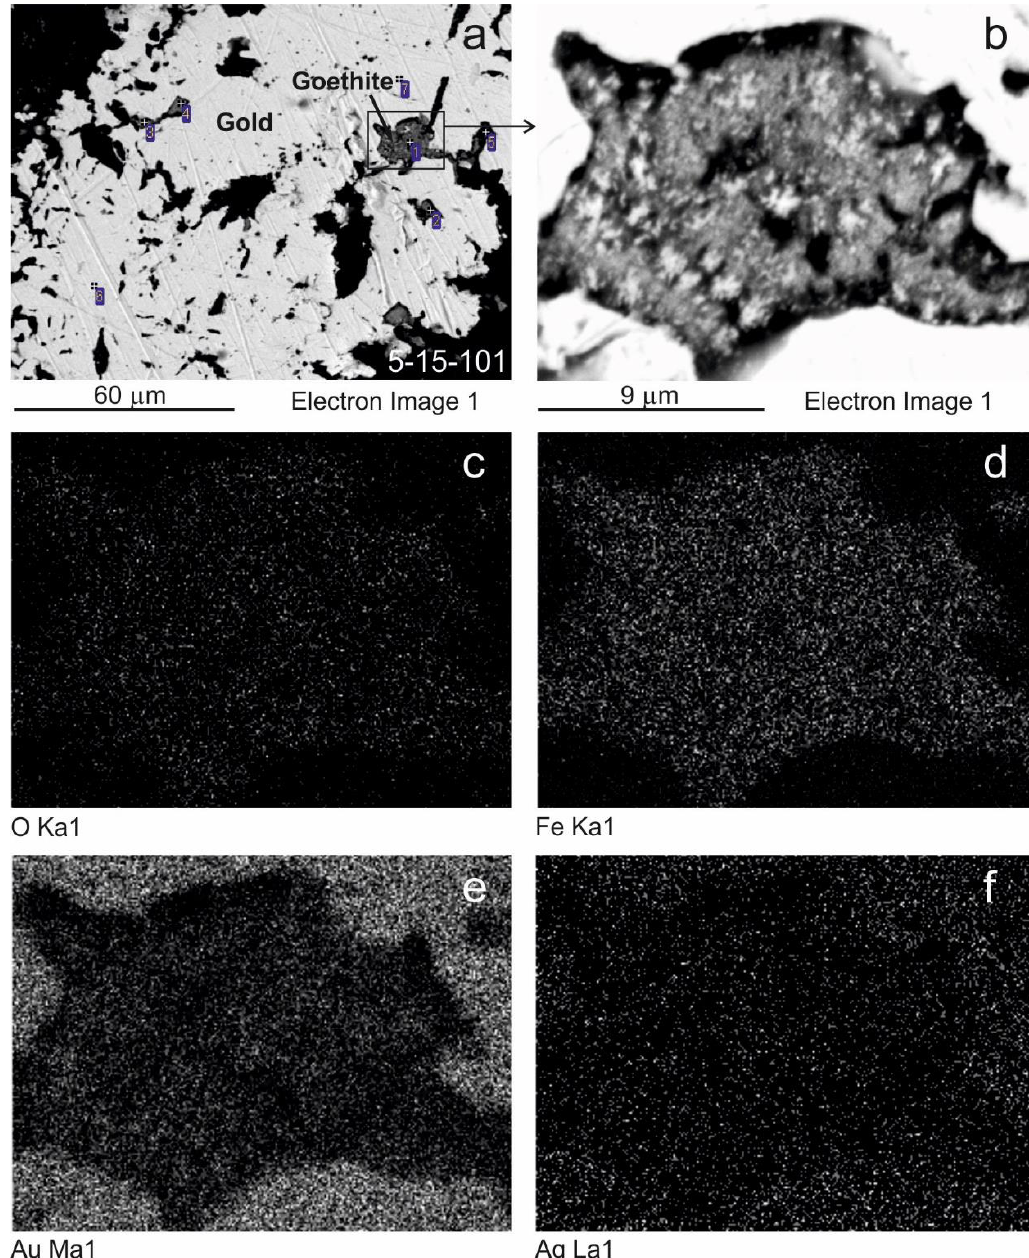
Figure 6. Massive gold with goethite: ( a ) general view, ( b ) enlarged goethite fragment with microinclusions of gold in backscattered electrons, ( c – f ) in X-rays of O, Fe, Au and Ag. Table 4. The composition (in wt %) and fineness (in ‰) of the massive gold (in wt%) shown in Figure 11.